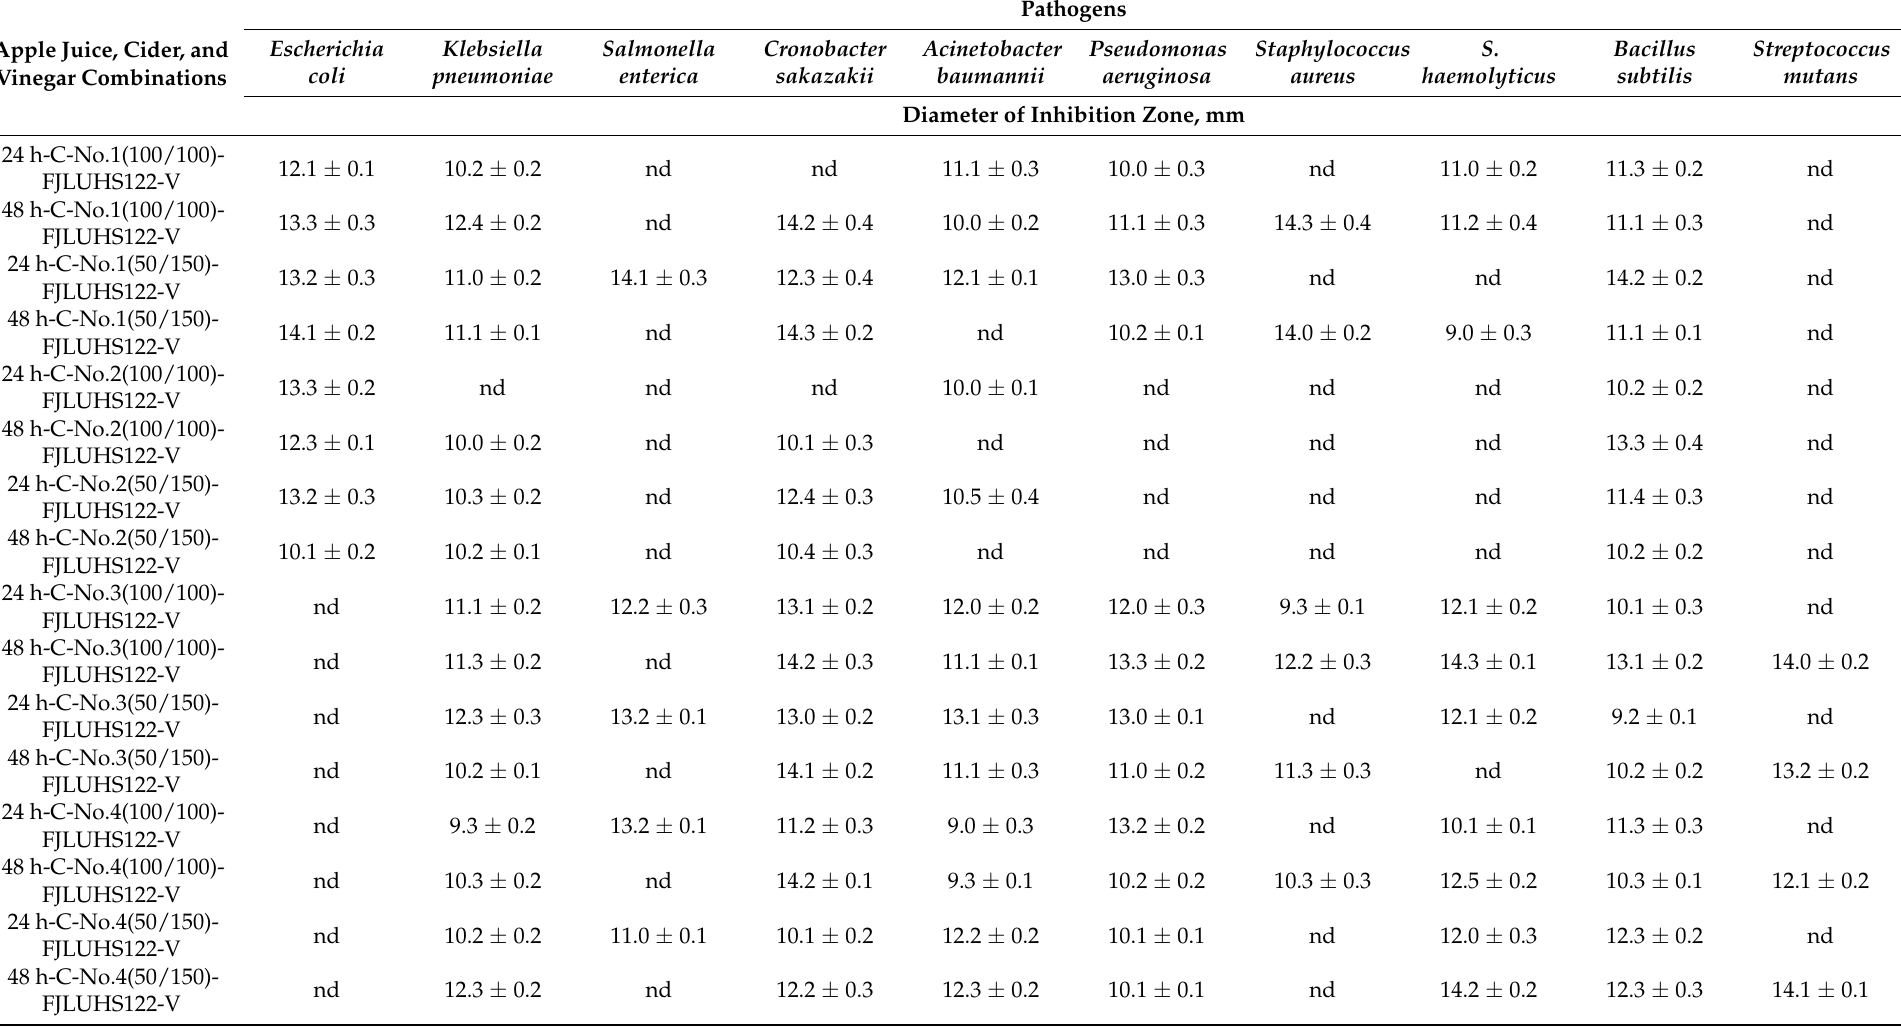
Table 11. Antimicrobial properties of apple juice, cider, and vinegar